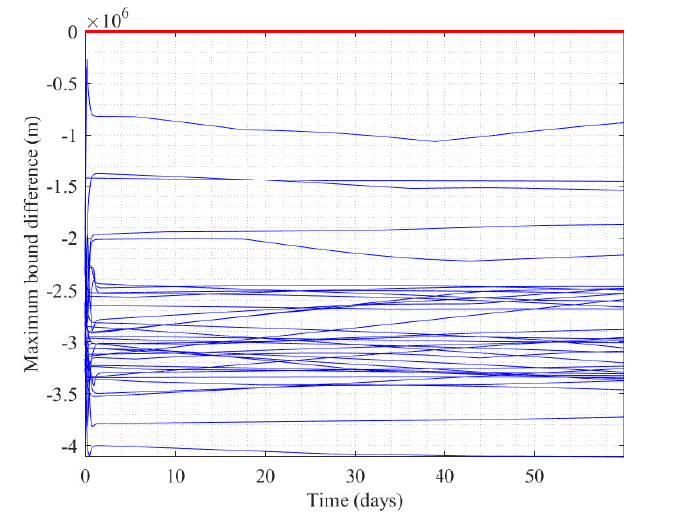
Figure 14. The differences in maximum bounds away from the corresponding constraints. Red line is zero-value standard. Blue lines are maximum bound